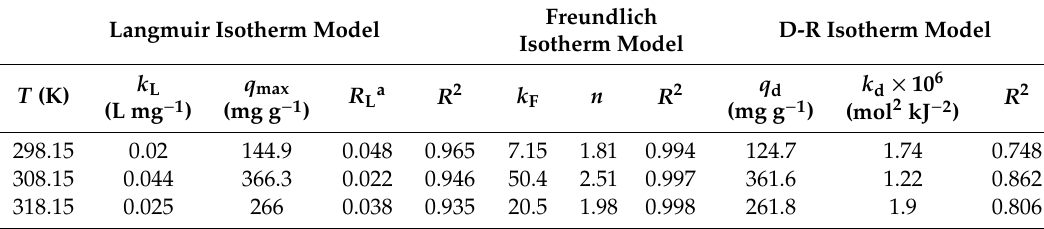
Table 3. Isotherm parameters for DCFS enrichment treated by TAPAM-PDA-Fe 3 O 4 at pH 8.0. Langmuir Isotherm